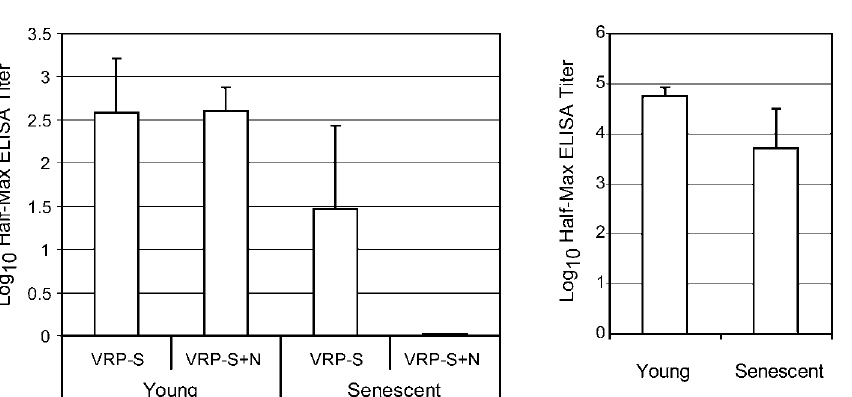
Figure 6. ELISA Titers for Anti-S and Anti-HA igG in Vaccinated Animals (A) Log 10 half-maximum ELISA titers for anti-S IgG antibody in aged mice vaccinated with VRP-S or VRP-S þ N when young (Table 1, experiment 2) or senescent (Table 1, experiment 4). Values represent mean values, and error bars indicate standard deviation. (B) Log 10 half-maximum ELISA titers for anti-HA IgG antibody in aged mice vaccinated when young (experiment 2) or senescent (experiment 4).